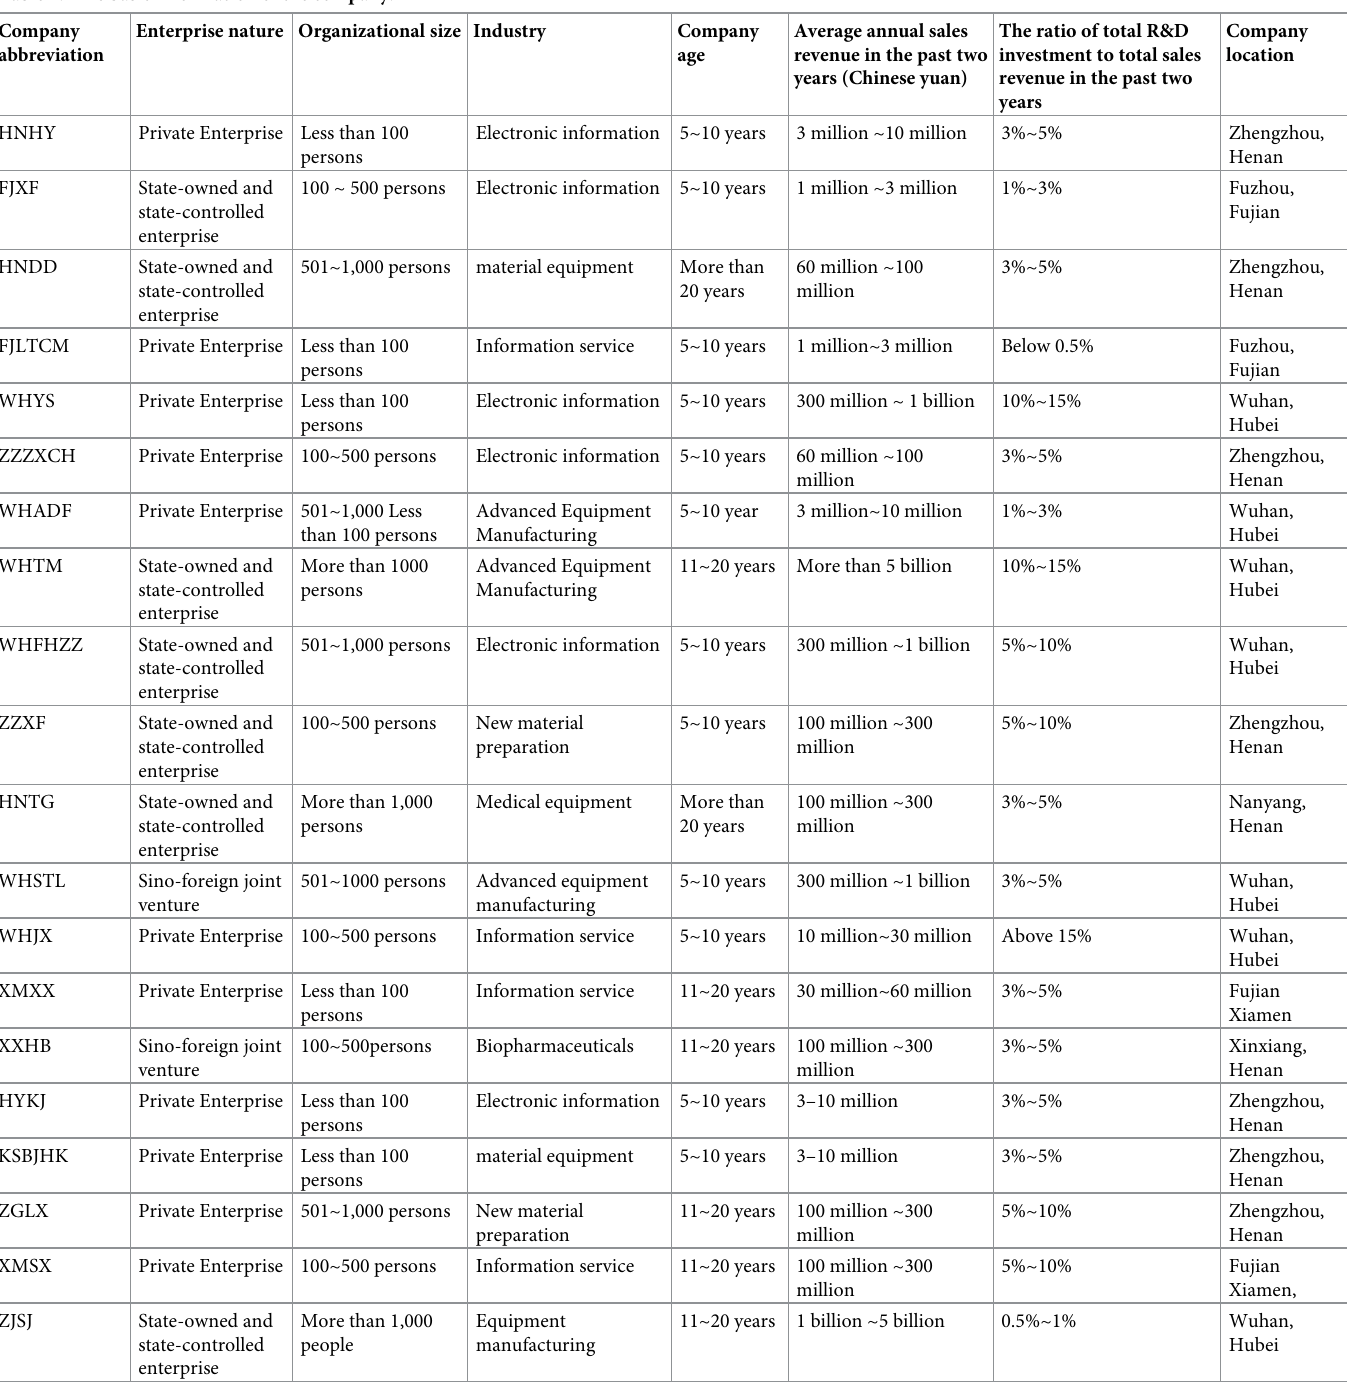
Table 1. The basic information of the